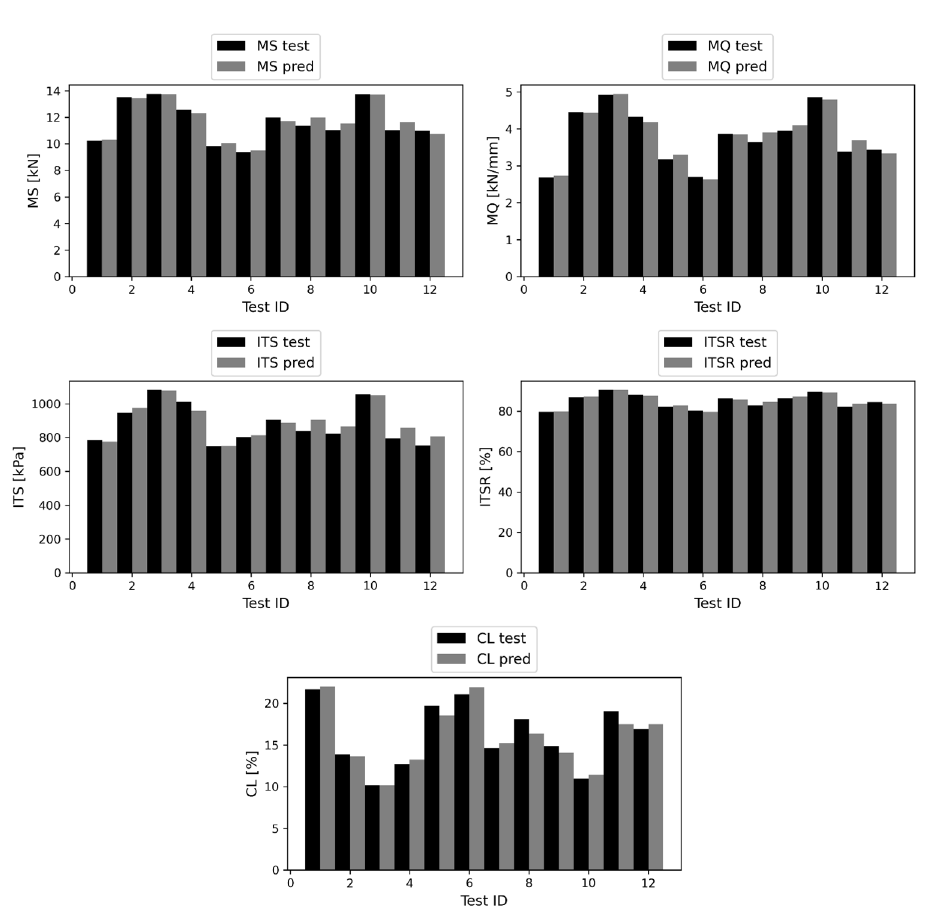
Figure 15. Test vectors and CatBoost predictions of MS (up-left), MQ (up-right), ITS (middle-left), ITSR (middle-right), CL